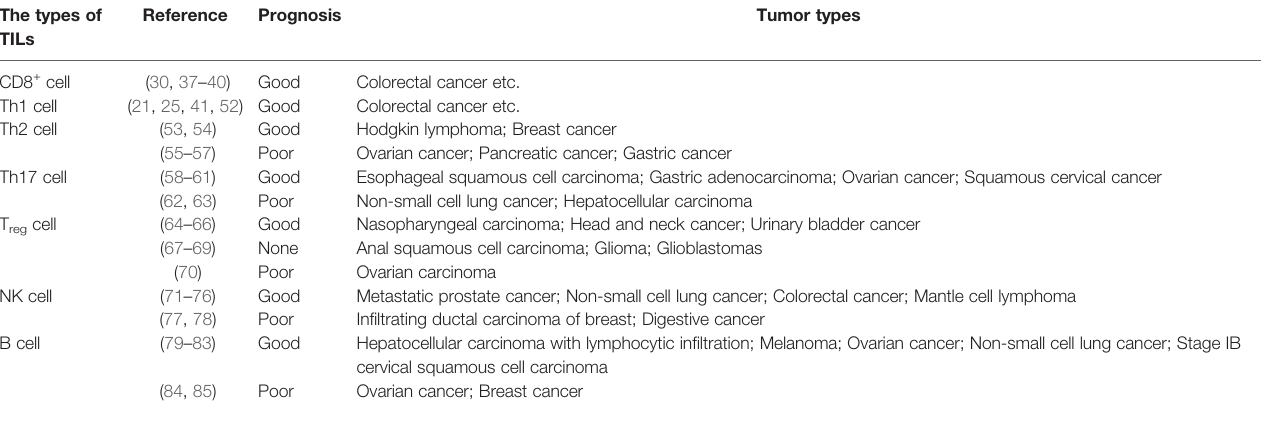
TABLE 2 | The association of different types of TILs with tumor